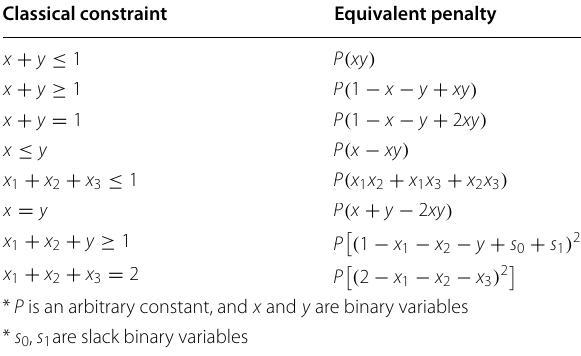
Table 1 Conversion table Classical constraint Equivalent penalty